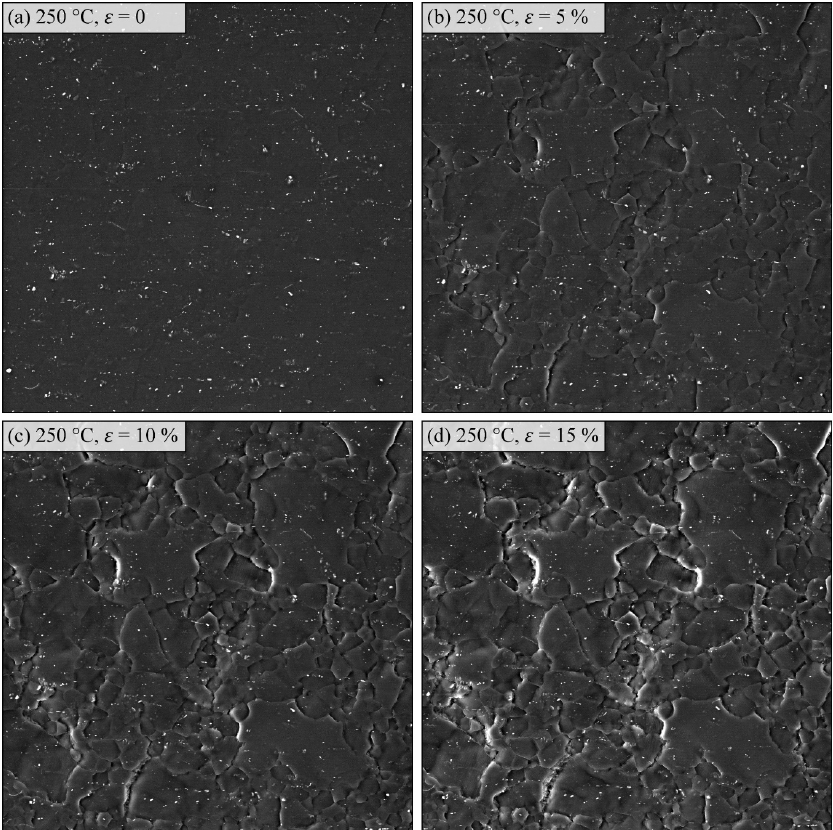
Figure A2. In the undeformed condition, the specimen surface has a dark grey appearance with uniformly distributed second-phase particles in bright contrast; Here, SEM images of ( a ) undeformed sample surface as well as continuously increased strain at ( b ) 5%, ( c ) 10%, and ( d ) 15%, are shown.